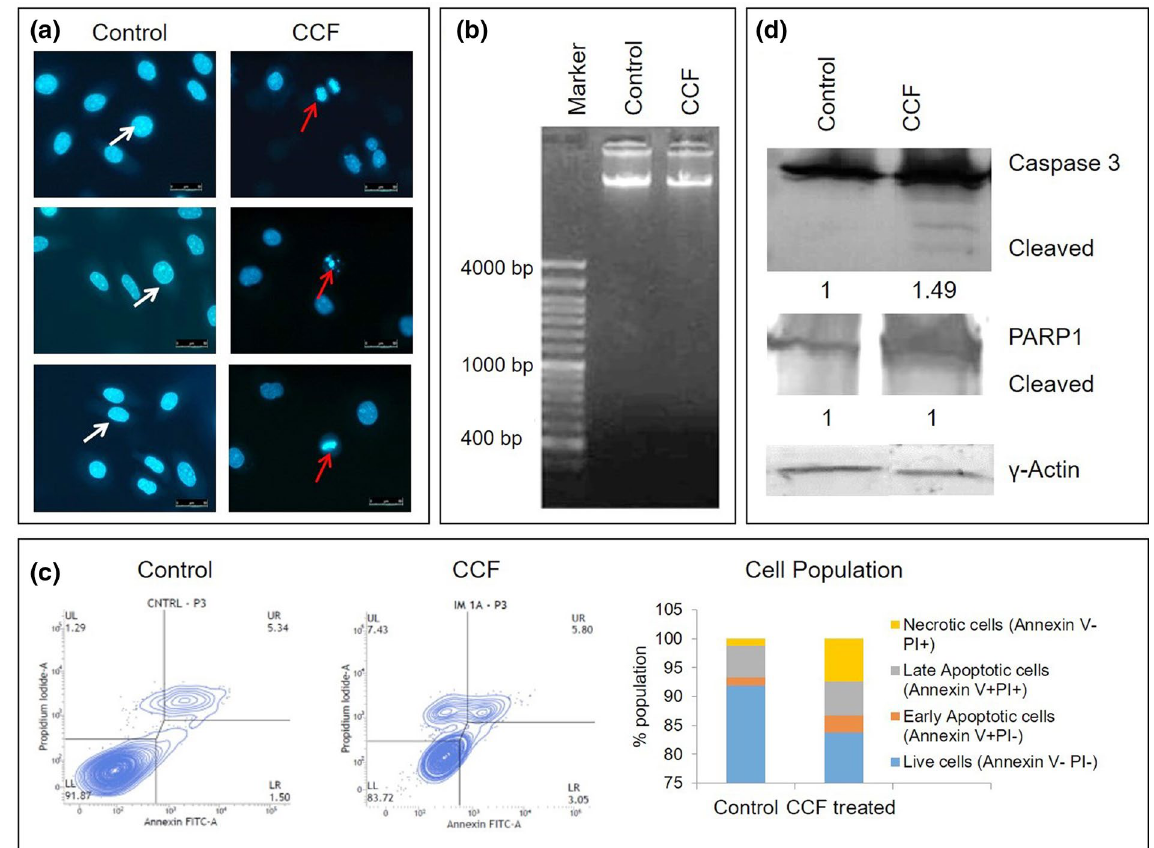
Figure 3. Elucidation of cell death pathway in CCF treated cells, ( a ) Nuclear morphology under fluorescence microscope, scale represents 50 µm, white arrows indicate ovoid shaped normal nuclei and red arrows indicate eroded nuclear morphology under 40 × magnification; ( b ) Extracted genomic DNA run in 1.5% agarose gel showing no DNA laddering; ( c ) Annexin V-FITC/PI assay showing scatter plots with each quadrant representing variable population of cells; LL: viable cells (annexin V − PI-), LR: early apoptotic cells (annexin V + PI-), UR: late apoptotic cells (annexin V + PI +) and UL: dead cells (annexin V − PI +), bar graph showing percentages of different populations of cells; ( d ) Protein expressions for Caspase3 and PARP1, γ-actin served as loading control. Densitometric analysis (ImageJ 1.52A ) showed fold changes of expressions of the proteins were presented below of respective blot pictures. [Blot figures for control and treated sets in ( d ) were cropped from same gel. Detailed information was given as Supplementary